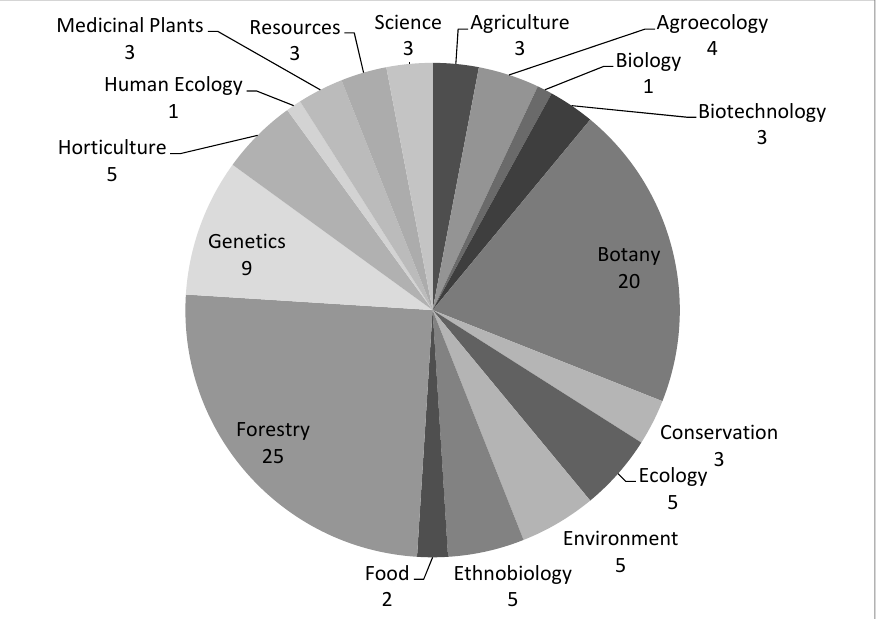
Figure 1. Proportion of articles from journals of different disciplines contributing to the literature on WEFs (wild edible fruits), in percentages ( n = 185).